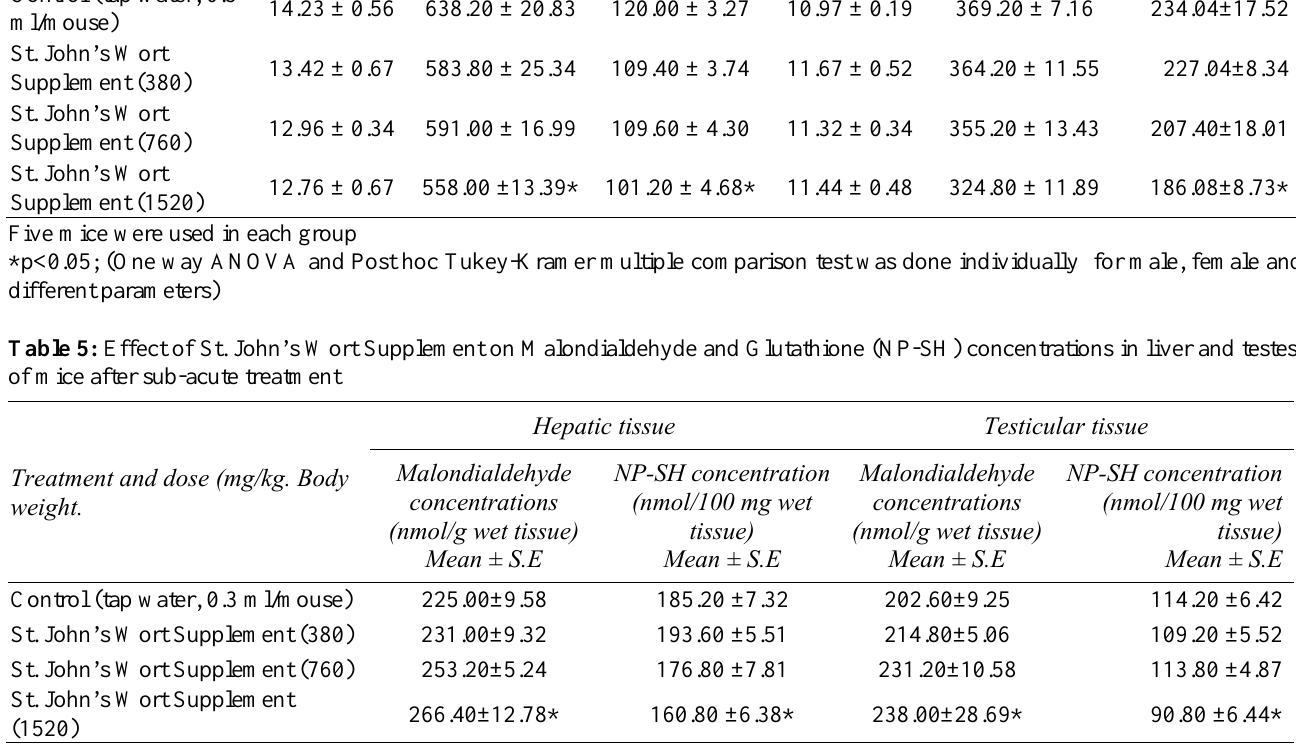
Five mice were used in each group different parameters)